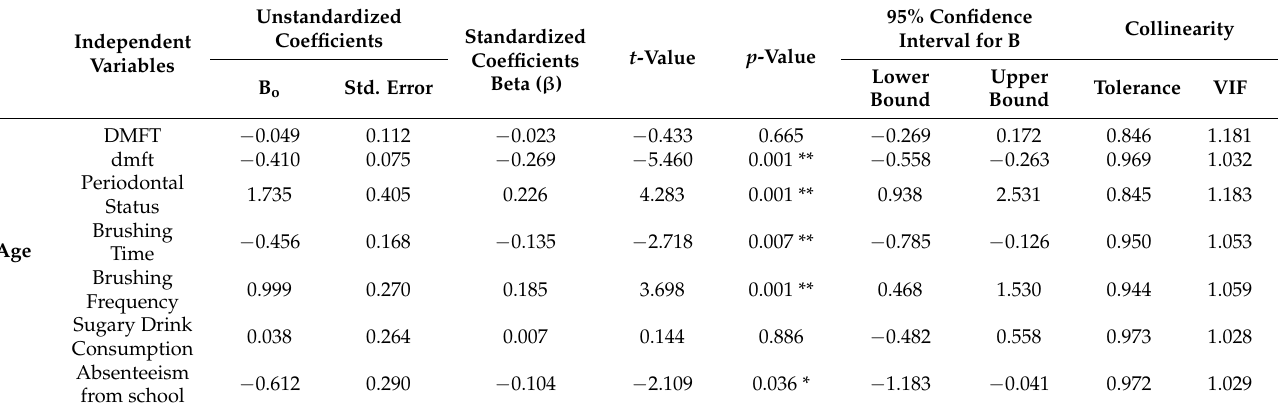
Table 4. Linear regression analysis of age and independent variables ( n =